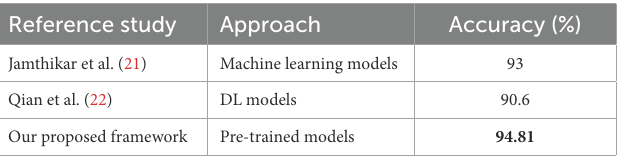
TABLE 5 Comparative accuracy of the proposed approach with previous proposed